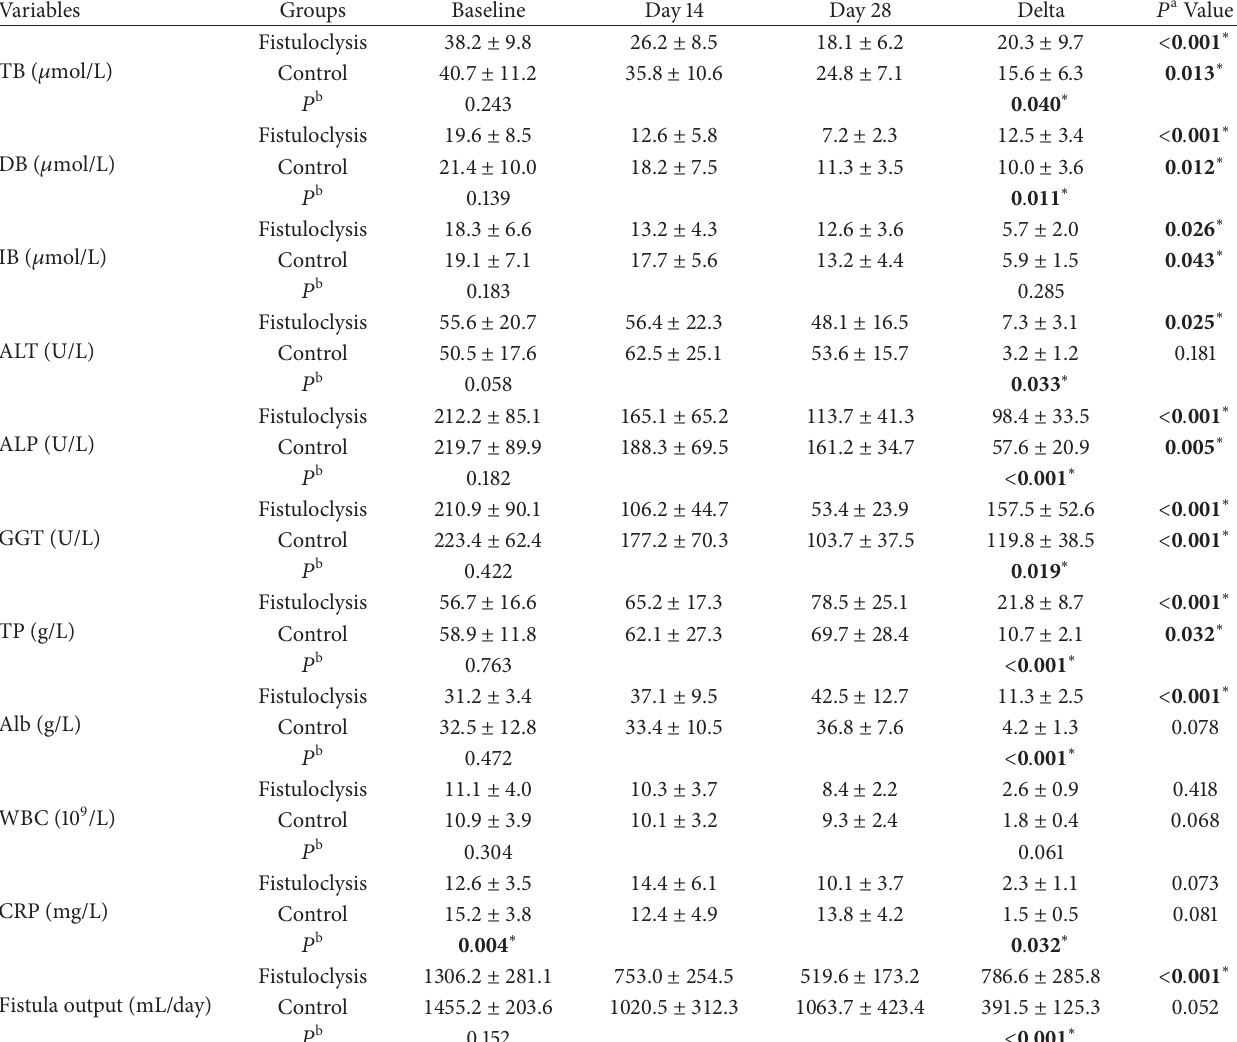
Table 3: Laboratory and clinical variables before and after 28-day treatments in the two groups.